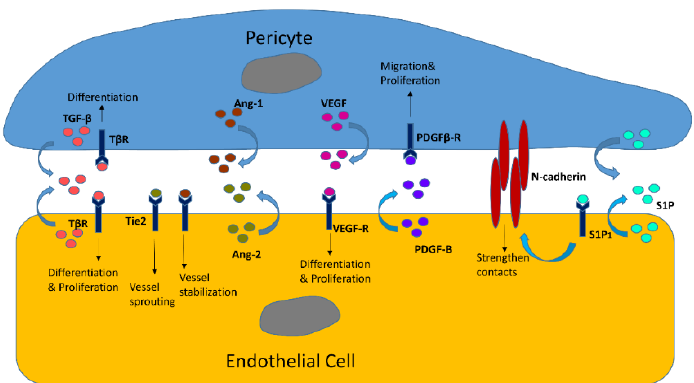
Figure 1. Interactions between endothelial cells and pericytes via secretory actions. ( 1 ) TGF- β could be produced by both pericytes and endothelial cells, mainly mediating differentiation of pericytes and endothelial cells. It also activates proliferation of endothelial cells; ( 2 ) angiopoietin-1 (Ang-1) from PCs and angiopoietin-2 (Ang-2) from ECs could combine Tie-2 in ECs (although a low level of Tie2 expression has been detected in pericytes, only a mild physiological phenotype was found after deletion of Tie-2 in PCs. The role of Ang-1/Tie-2 signal in pericytes still remains controversial); ( 3 ) VEGF, mainly derived from mesenchymal cells (pericytes), is responsible for differentiation into pericytes. Similar to TGF- β , it could also trigger proliferation of ECs. VEGF ligands include VEGF-A, B, C, D, E and receptors mainly include VEGFR1 and VEGFR2. Normally, VEGFR1 binds to VEGF-A and B, while VEGFR2 binds to VEGF-A, C, D, and E; ( 4 ) PDGF-B, derived from endothelial cells, is found in angiogenic sprouts and remodeling arteries. It triggers migration and proliferation of pericytes via combination with PDGFR- β ; ( 5 ) sphingosine-1-phosphate (S1P) is expressed in endothelial cells. Its signaling pathway strengthens the contacts between endothelial cells and N-cadherin, which induces migration of pericytes toward endothelial cells and further stabilizes the combination of two cells.